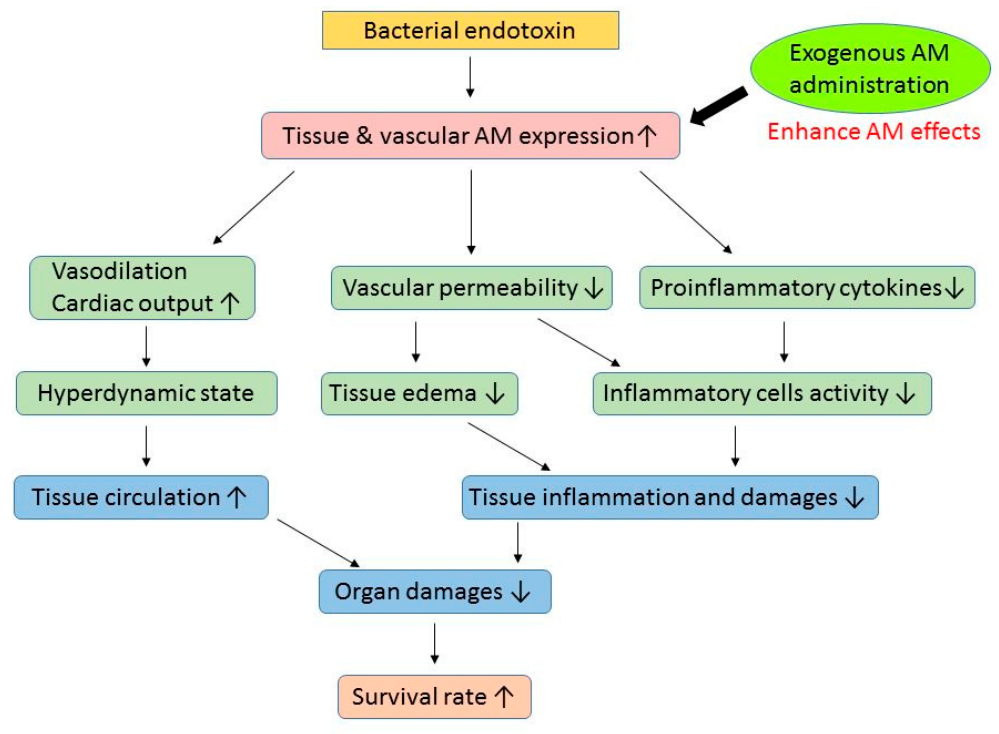
Figure 3. Simplified adrenomedullin cascade, an organ-protective factor against sepsis . AM: adre- nomedullin.